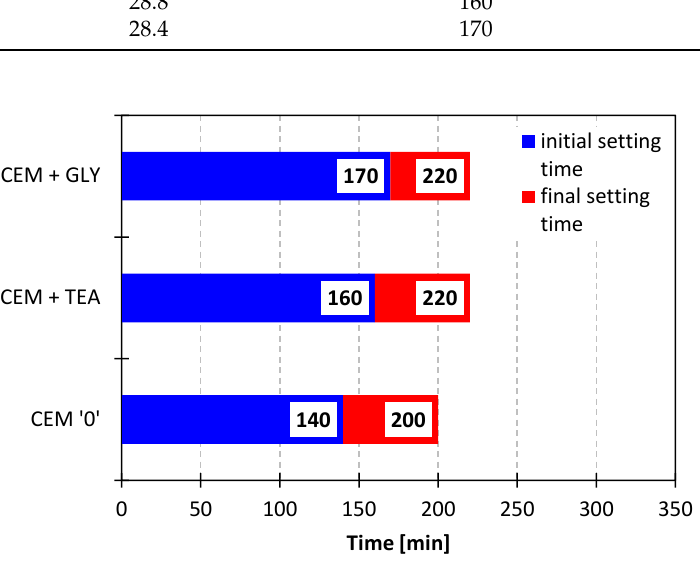
Figure 3. Initial and final setting times of cements.